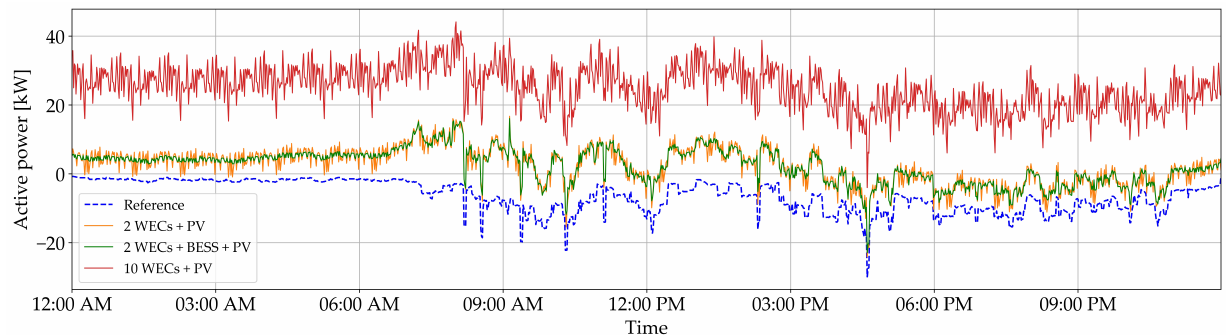
Figure 19. Active power exchange of the LVTF and upstream network at the swing bus for various scenarios in case study 3.